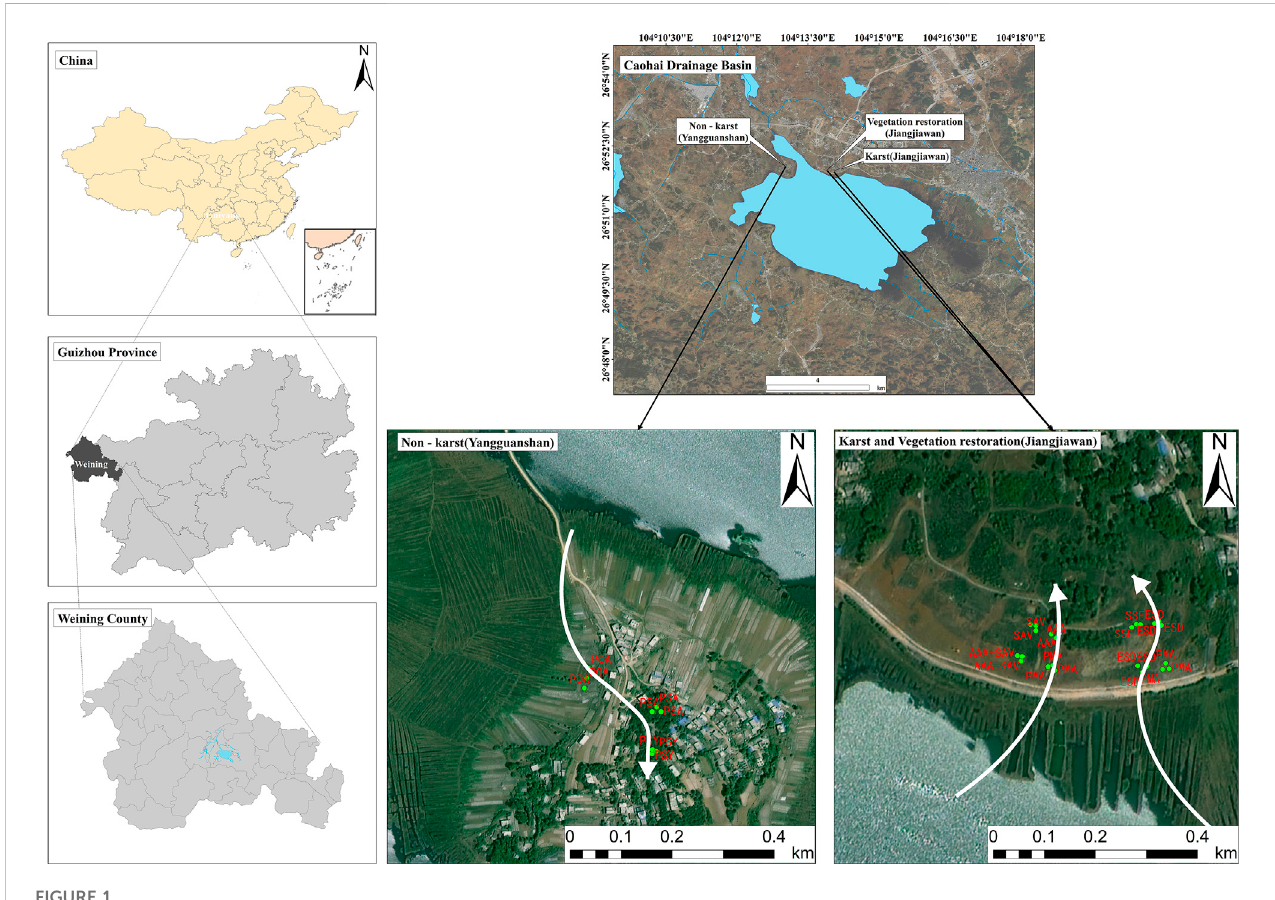
FIGURE 1 Location of the study area, Caohai.